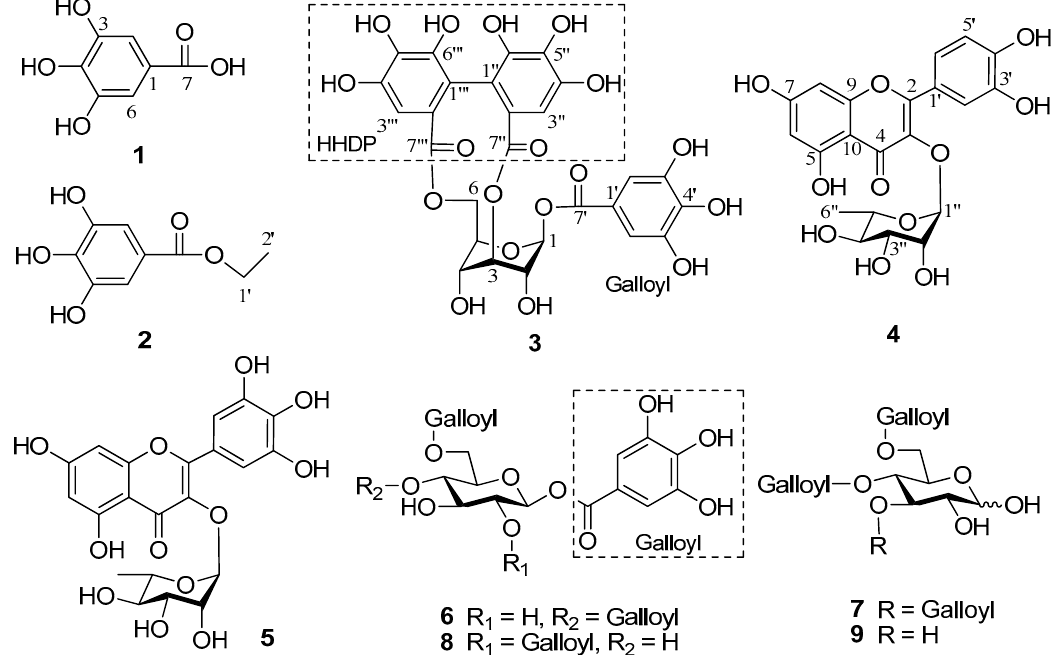
Figure 1. Structures of compounds ( 1 – 9 ) isolated from Ricinodendron heudelotii.